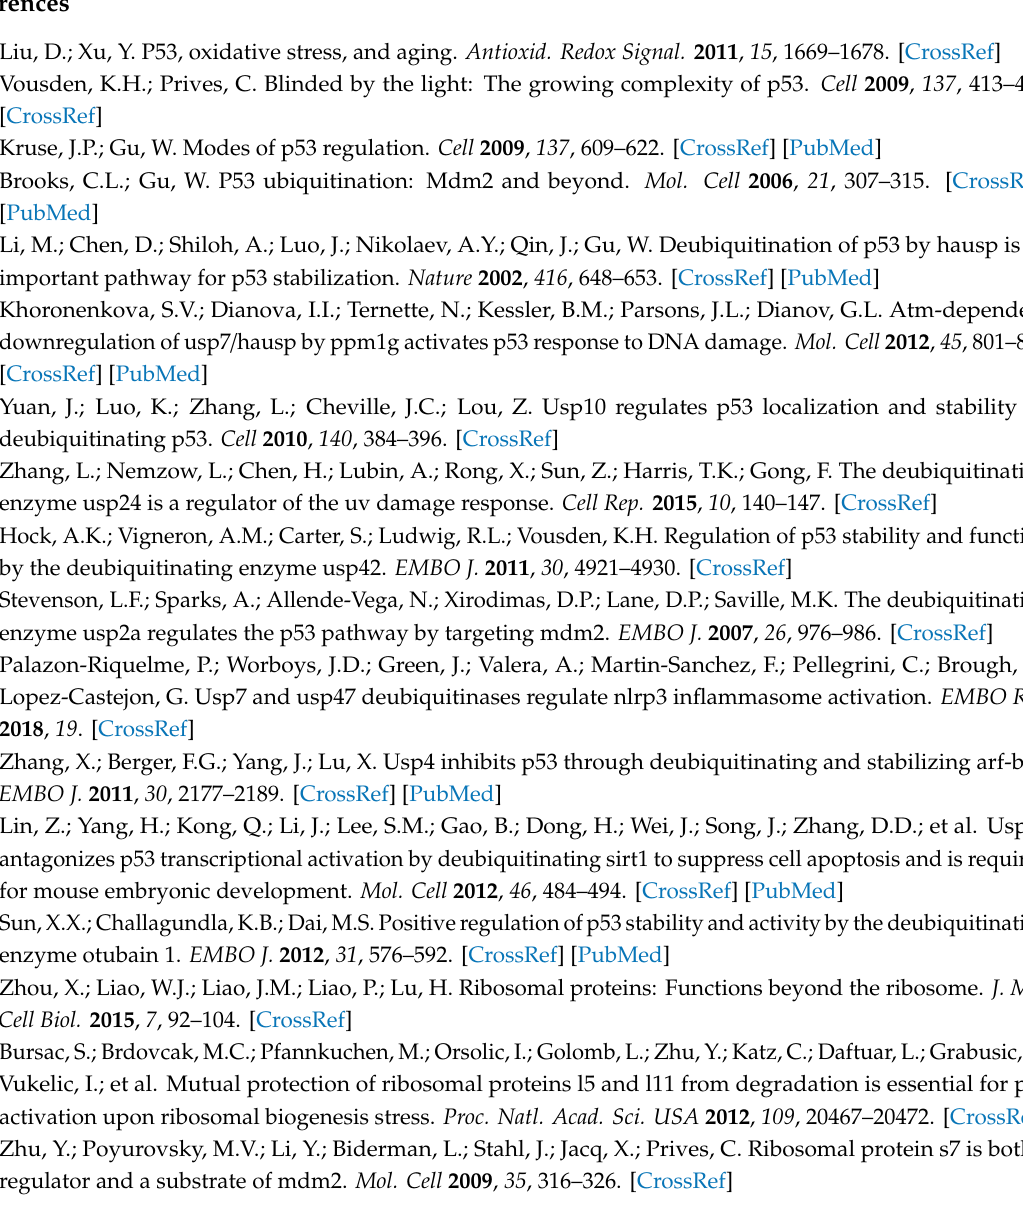
Figure S1: Overexpressed USP47 interacts with endogenous RPS2 in cells. Figure S2: USP47 depletion induces p53 protein level. Figure S3: MDM2 does not have any e ff ect on the interaction between USP47 and RPS2. Figure S4: MDM2 ubiquitination is increased by RPS2 and restored by USP47. Figure S5: The ubiquitination of endogenous RPS2 is accumulated with Actinomycin D treatment in a time-dependent manner. Figure S6: Inhibition of xenograft tumor by knockdown of USP47. Figure S7: The uncropped blots and molecular weight markers of the Figure 1 Figure 2 Figure 3 Figure 4 Figure 5 Figure 6 Figure 7 in main